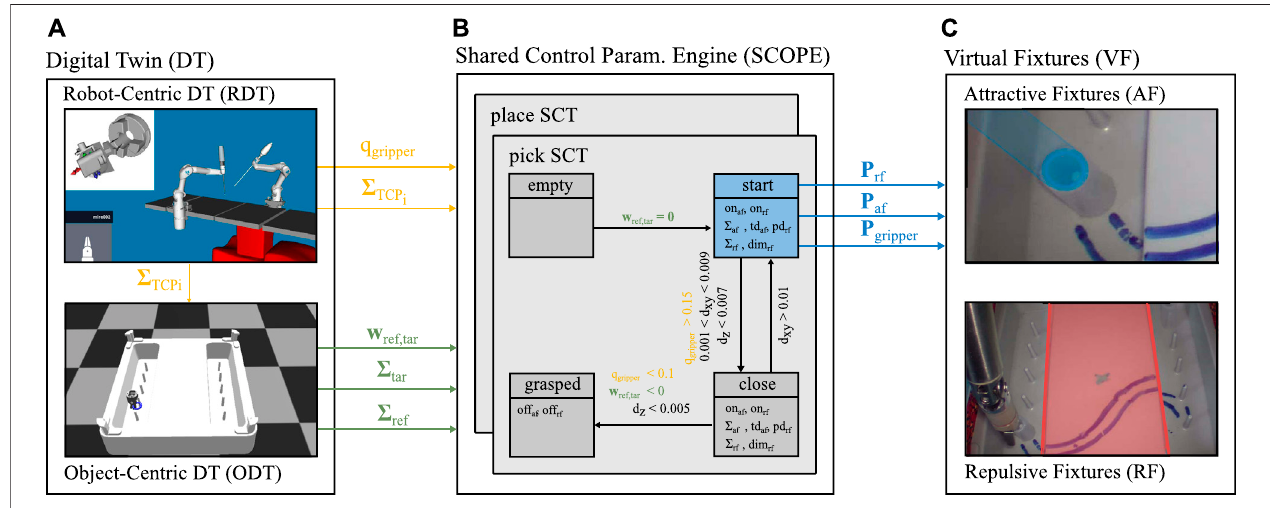
FIGURE 2 | Overview of the three core components and their interaction within the proposed concept. Virtual fi xtures (A) are introduced in Section 3.1. The parametersaredeterminedbySCOPE (B) ,whichisdescribedinSection3.2.SCOPErequiresthetaskcontext,whichisprovidedbythedigitaltwinDT, (C) ,asdescribed in Section